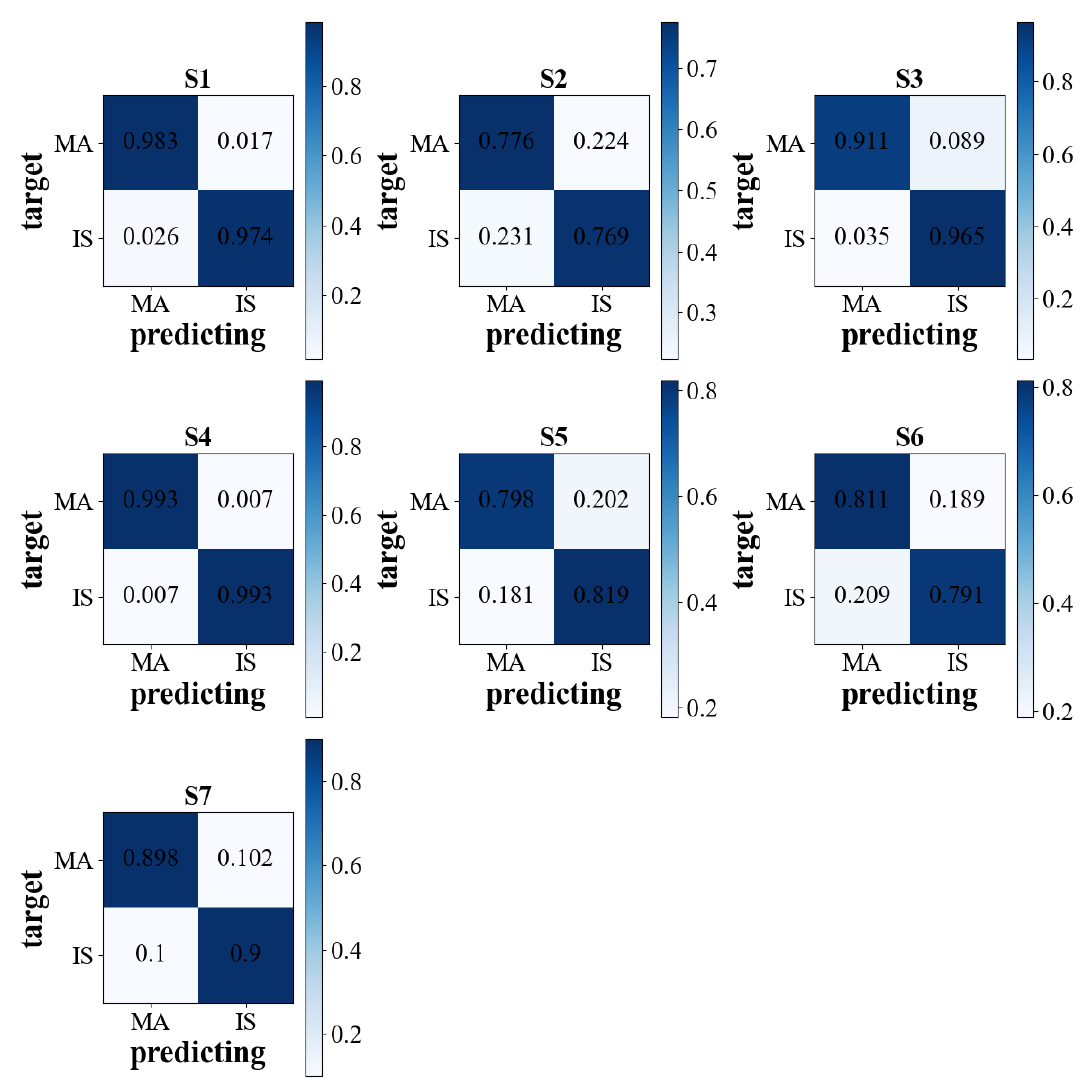
Figure 8. The confusion matrices for all subjects with the LSTM&VS method.